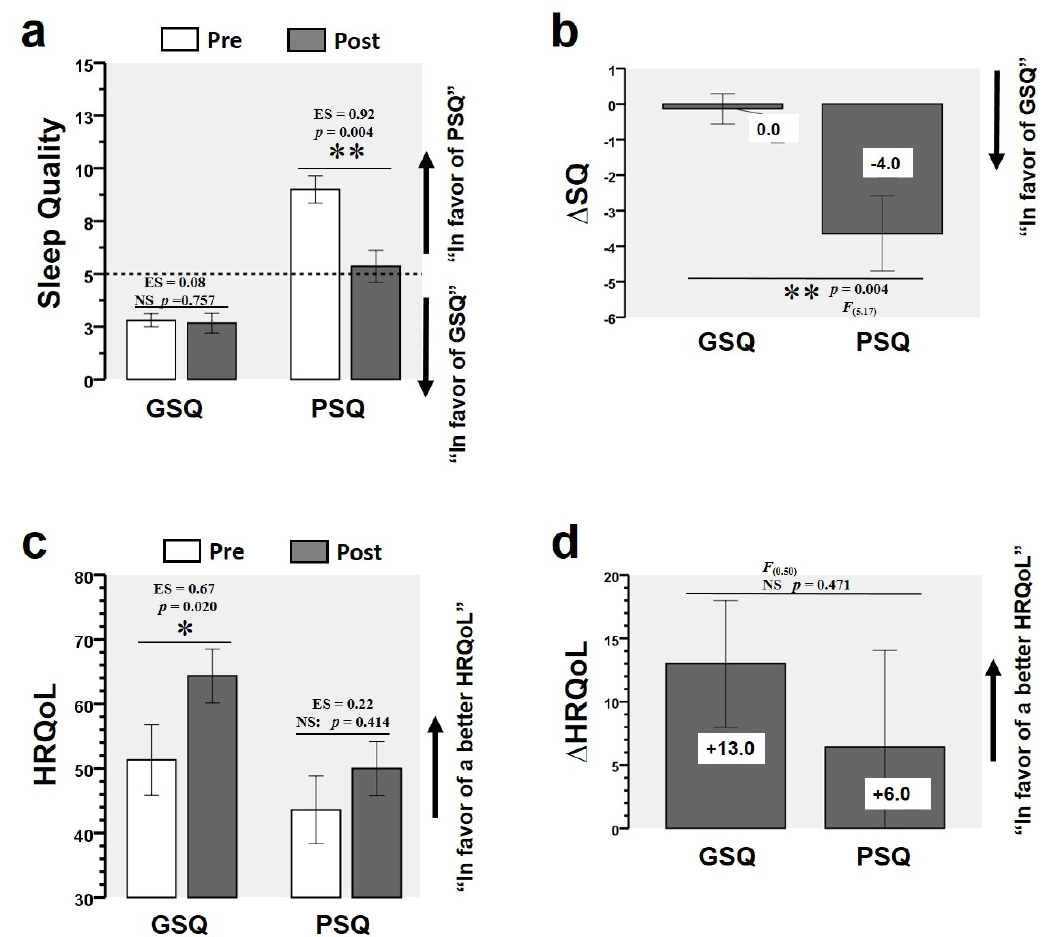
Figure 4. Changes in sleep quality (SQ) and in health-related quality of life (HRQoL) for the good-sleep-quality group (GSQ) and poor-sleep-quality (PSQ) group. ( ∆ ) denotes delta changes from pre to post intervention. (ES) denotes e ff ect size. (F) denotes the Levene test. (*) denotes significant differences between groups ( p < 0.05). (**) denotes significant differences between groups ( p < 0.01). (NS) denotes no significant differences. In the GSQ group, there were no changes in the pre- and post- intervention SQ scores ( p = 0.757) ( a ). By contrast, the PSQ group showed significant changes between pre- and post-intervention values (9.00 ± 2.42 vs. 5.36 ± 2.84, ES = 0.92, p = 0.004) ( a ). Comparing pre- and post-intervention in the GSQ group, there were changes in the HRQoL general health score (51.33 ± 21.08 vs. 64.33 ± 16.24, ES = 0.67, p = 0.020) ( c ). By contrast, the PSQ group showed no significant changes between pre- and post-intervention ( p = 0.414) ( c ). There was a time × group interaction in ∆ SQ between the GSQ and PSQ groups ( ∆ 0.0 vs. ∆ − 4.0, F = 0.50 p = 0.004) ( b ). There was no time × group interaction in the HRQoL between the GSQ and PSQ groups ( d